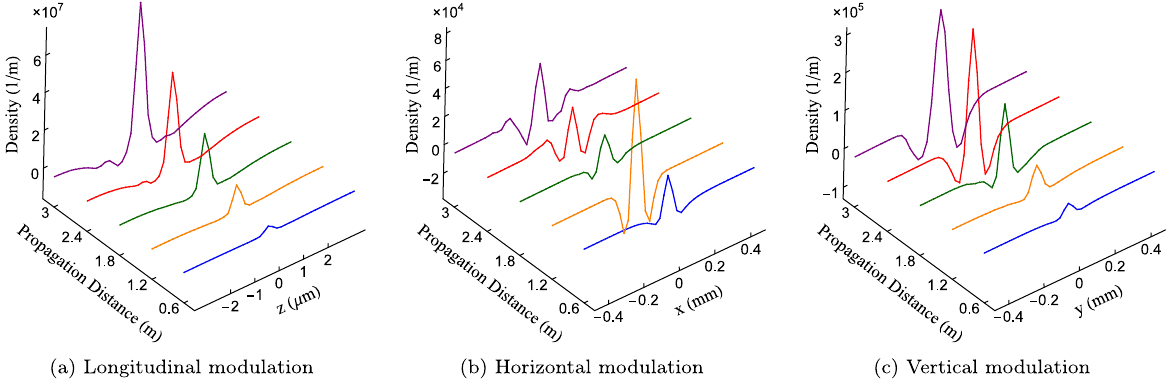
FIG. 13. PHAD simulations of density modulations of a Gaussian electron beam due to a centered ion copropagating through the modulator section of the PoP CeC at RHIC: (a) longitudinal direction, (b) horizontal direction, and (c) vertical direction. The density modulations are shown at propagation distances: 0.6 m (blue), 1.2 m (orange), 1.8 m (green), 2.4 m (red), and 3 m